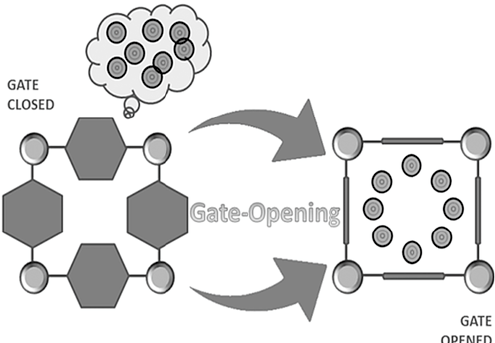
Figure 21. Illustration of the gate-opening effect. Reproduced with permission from [81]. Copyright Wiley-VCH, 2016.